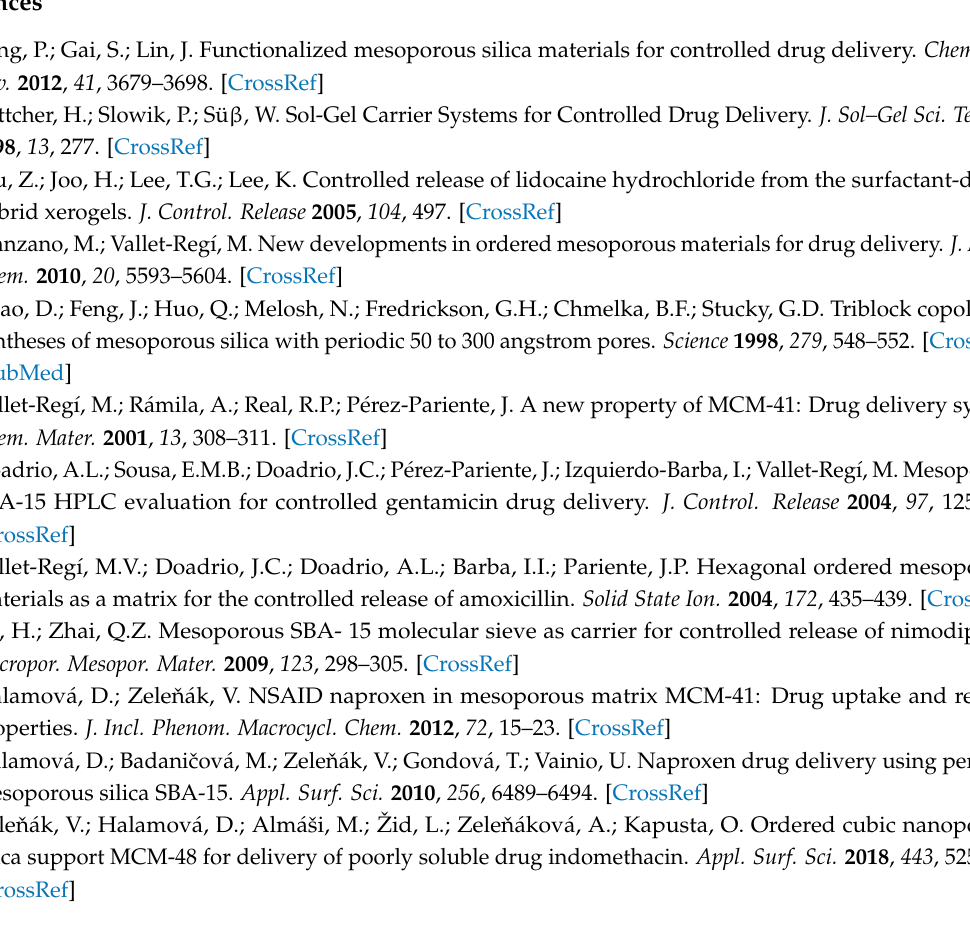
summarized in Table 1. Data acquisition, analysis, and reporting were performed using the Chromeleon Chromatography software, Version 7.2 (Thermo Fisher Scientific, Braunschweig,